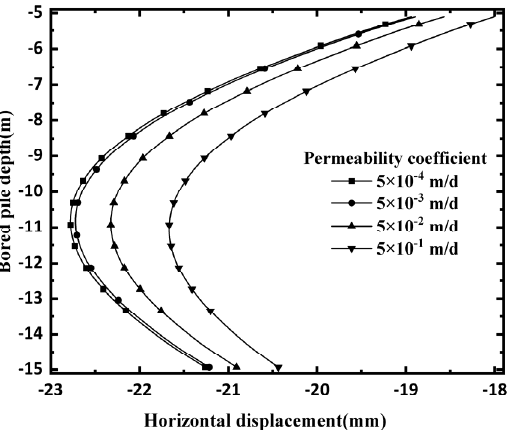
Figure 13. Horizontal displacement of different permeability coefficients without waterproof curtain.